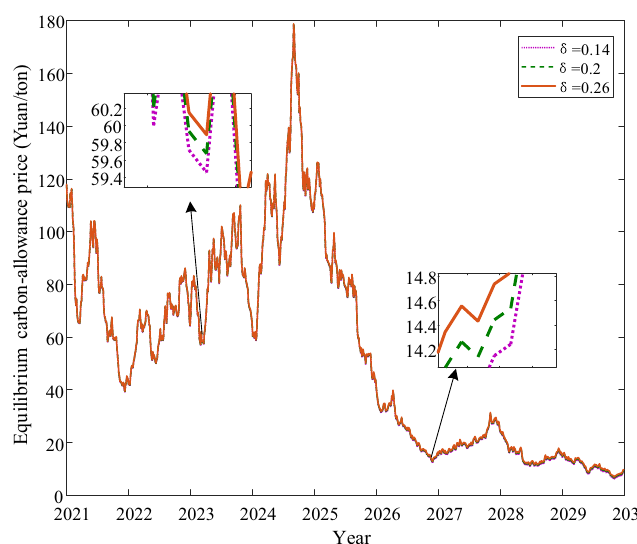
Fig. 10 Equilibrium prices of carbon allowances with different depreciation rates of carbon abatement